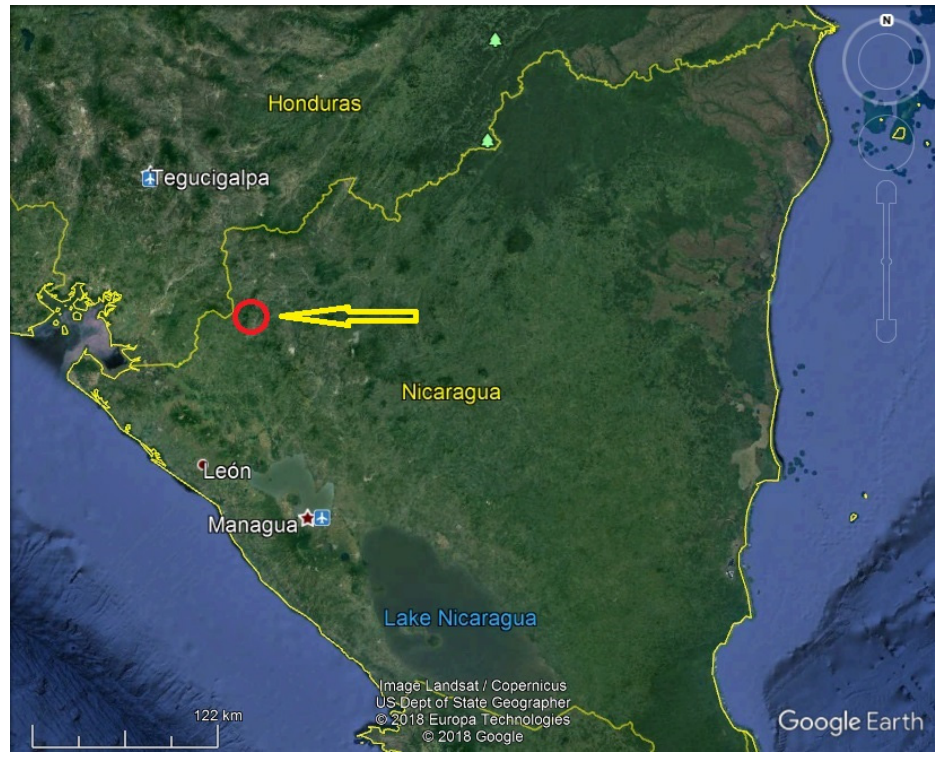
Figure 2. Location of the research area in the map of Nicaragua (red circle). Source: Google Earth. The Tepesomoto ‐ Pataste Mountains represent a continuous chain of summits that are aligned along an ancient fault of the Tertiary period, where a series of coalescing base volcanoes arose [51] (p. 4). The average altitude is 1280 m a.s.l.; Buena Vista (1665 m a.s.l. ), El Arenal (1625 m a.s.l. ), Apante